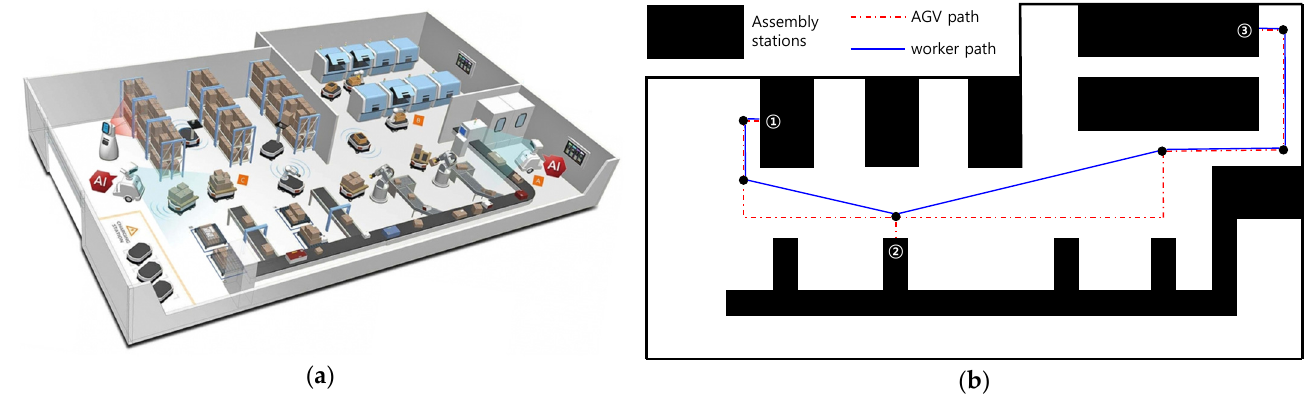
Figure 11. Control inputs for the MWR: ( a ) Linear and angular speed of the robot; ( b ) Rotational speed of Mecanum wheel motor.